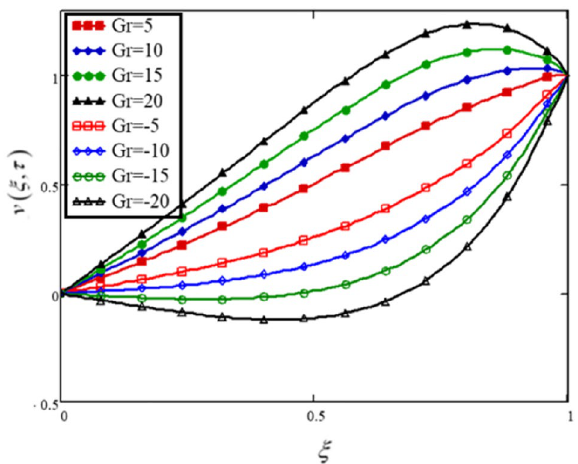
Figure 4. The effect of the Grashof number on the velocity profile of a hybrid nanofluid of the Brinkman type.